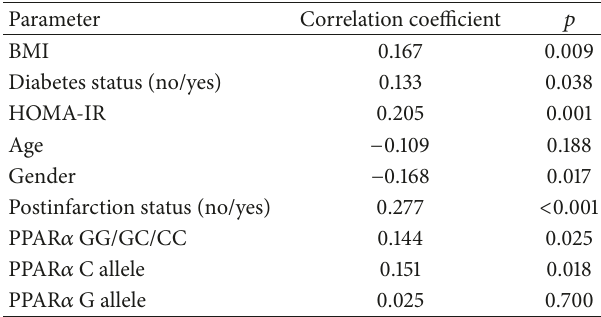
Table 4: Correlation between serum fetuin-A and investigated parameters (𝑛 = 244) .